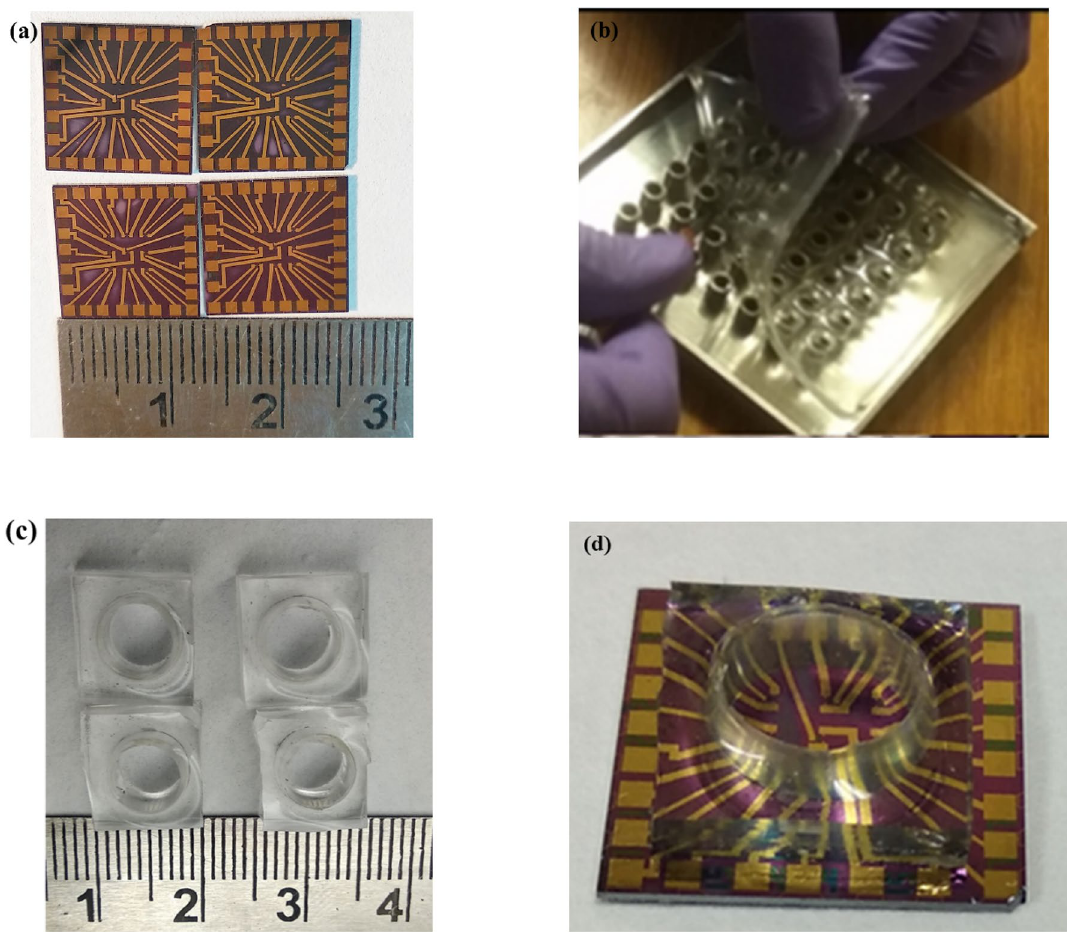
Figure 4. ( a ) Photos of individual chips after dicing, ( b ) peeling off the cured well array from SS stencil ( c ) individual well after dicing, and ( d ) fixing of PDMS well over the fabricated chip.